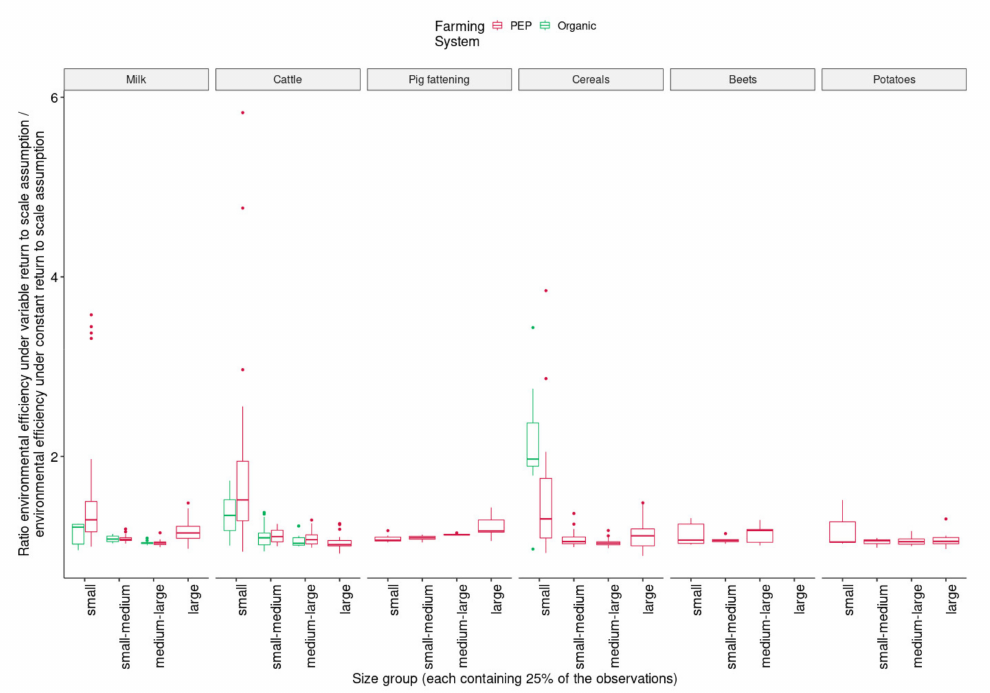
Figure 6. Comparison of environmental efficiency under constant return to scale assumption vs. variable return to scale assumption. The environmental efficiency was calculated twice, with both, constant and variable return to scale assumption. The ratio of the environmental efficiency scores indicates in-efficiency due to too small or too large product group size. (Omitted values for Vegetables and Fruits and subgroups with less than five